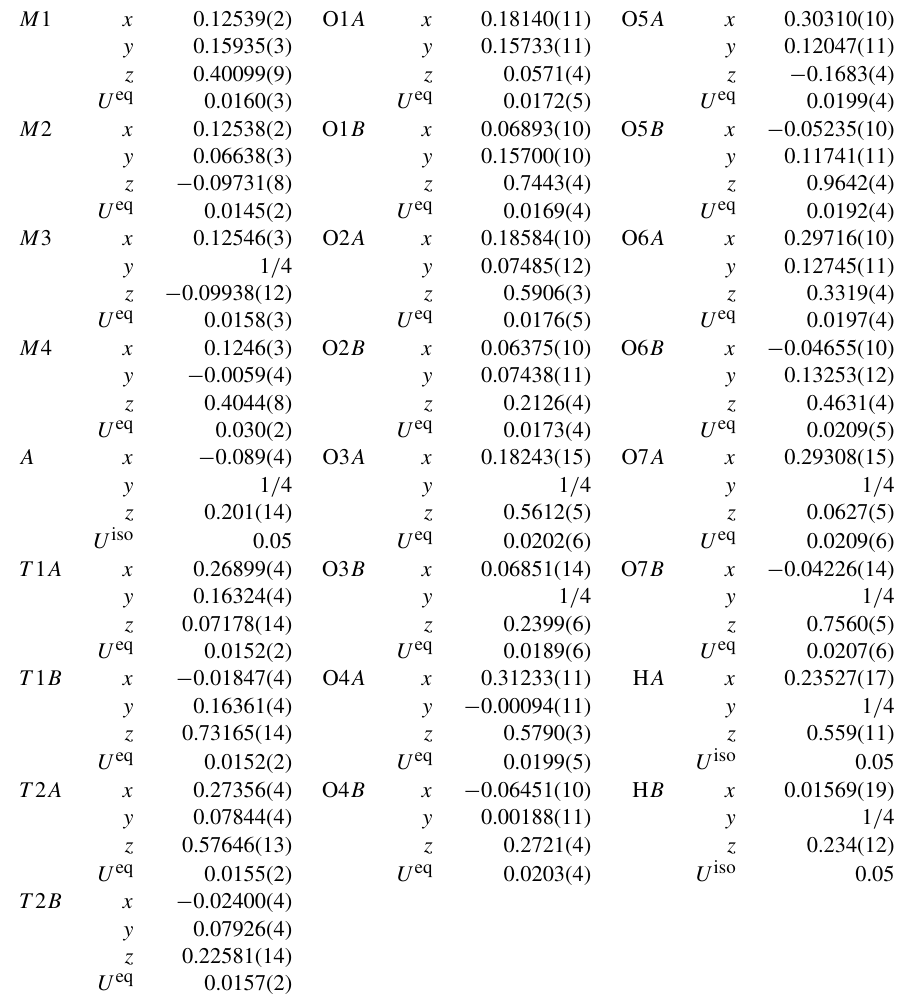
Table 4. Refined atom positions and displacement parameters (Å 2 ) of